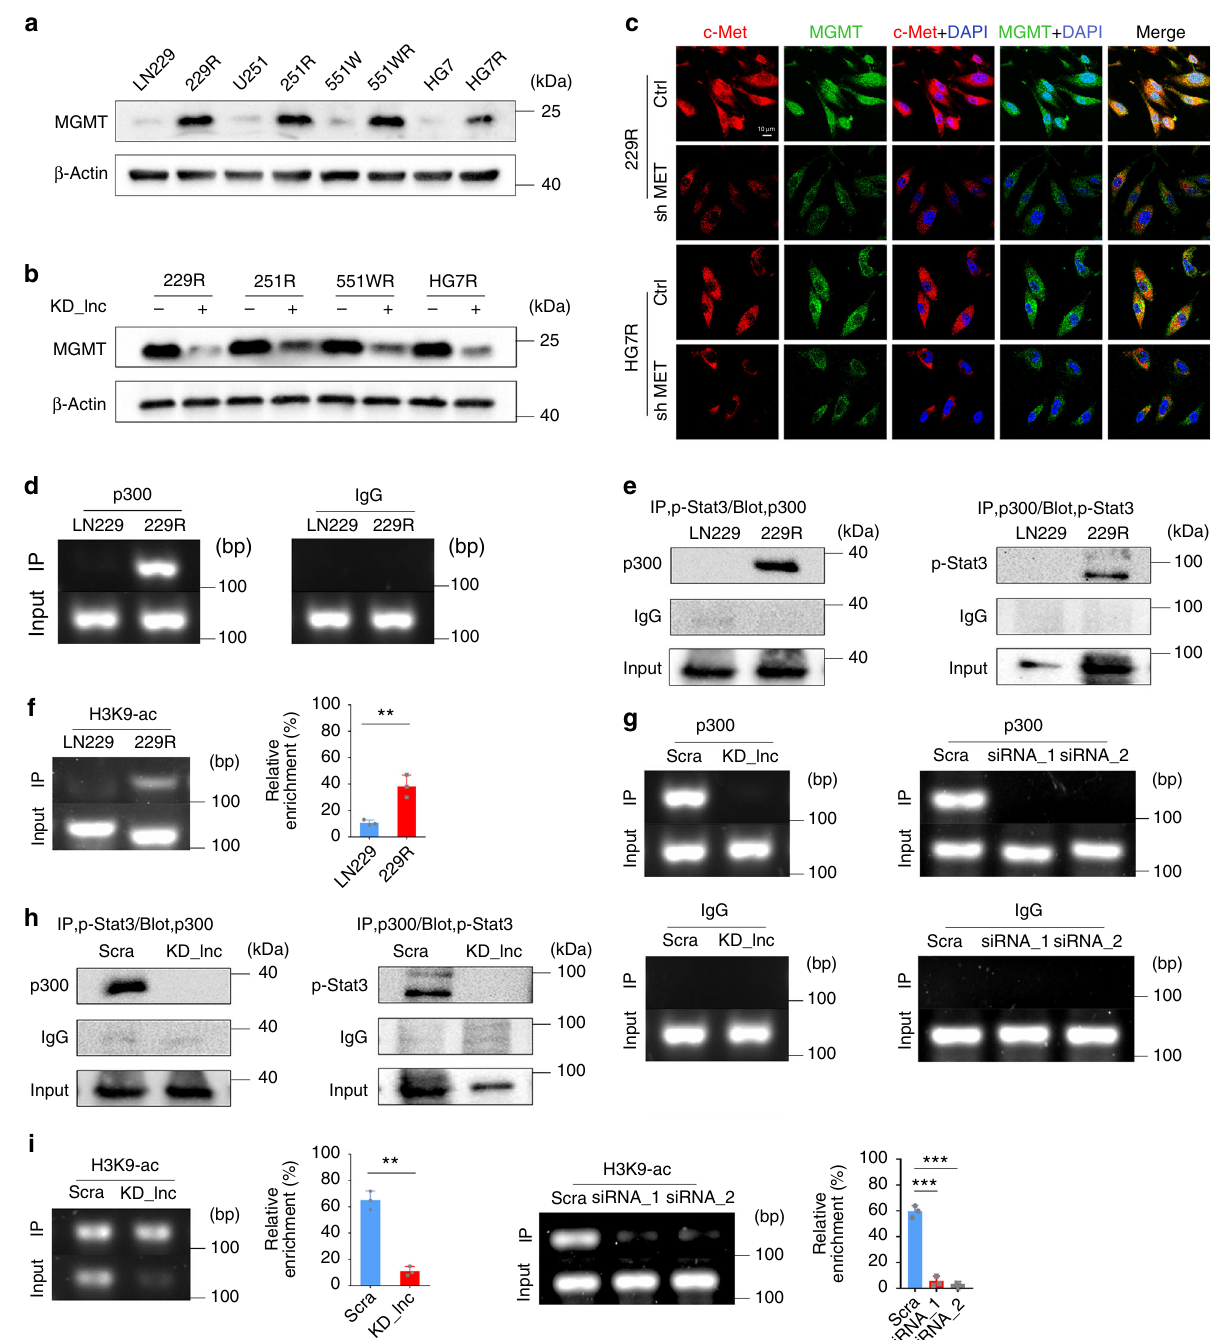
Fig. 6 The Lnc-TALC/c-Met axis activating the Stat3/p300 complex increases MGMT expression by modulating the acetylation of histone H3. a Western blot analysis of MGMT expression in TMZ-resistant and parental GBM cells. b Western blot analysis of MGMT expression in TMZ-resistant GBM cells transfected with LV-CRISPR-lnc-TALC. c Immuno fl uorescence analysis of MGMT and c-Met in TMZ-resistant GBM cells transfected with sh-MET. The nuclei were stained with DAPI. Scale bar = 10 μ m. d ChIP assay of the enrichment of p300 in the MGMT promoter region normalized to IgG in LN229 and 229R GBM cells ( n = 3). e Left: Immunoprecipitation of 229R and LN229 GBM cells with an antibody against p-Stat3 followed by labeling with an anti- p300 antibody. Right: Immunoprecipitation of 229R and LN229 GBM cells with an antibody against p300; the cells were subsequently labeled with the anti-p-Stat3 antibody. f ChIP assay of the enrichment of H3K9ac in the MGMT promoter region normalized to IgG in LN229 and 229R GBM cells ( n = 3). g ChIP assay of the enrichment of p300 in the MGMT promoter region normalized to IgG in 229R GBM cells transfected with LV-CRISPR-lnc-TALC and si- Stat3 ( n = 3). h Left: Immunoprecipitation of 229R GBM cells after knocking down lnc-TALC with an antibody against p-Stat3 followed by labeling with an anti-p300 antibody. Right: Immunoprecipitation of 229R GBM cells knocking down lnc-TALC with an antibody against p300 followed by labeling with an anti-p-Stat3 antibody. i ChIP assay of the enrichment of H3K9ac in the MGMT promoter region normalized to IgG in 229R GBM cells transfected with LV- CRISPR-lnc-TALC and si-Stat3 ( n = 3). Data are presented as the mean ± S.D. P value was determined by Student ’ s t -test. Signi fi cant results were presented as NS non-signi fi cant, * P < 0.05, ** P < 0.01, or *** P <